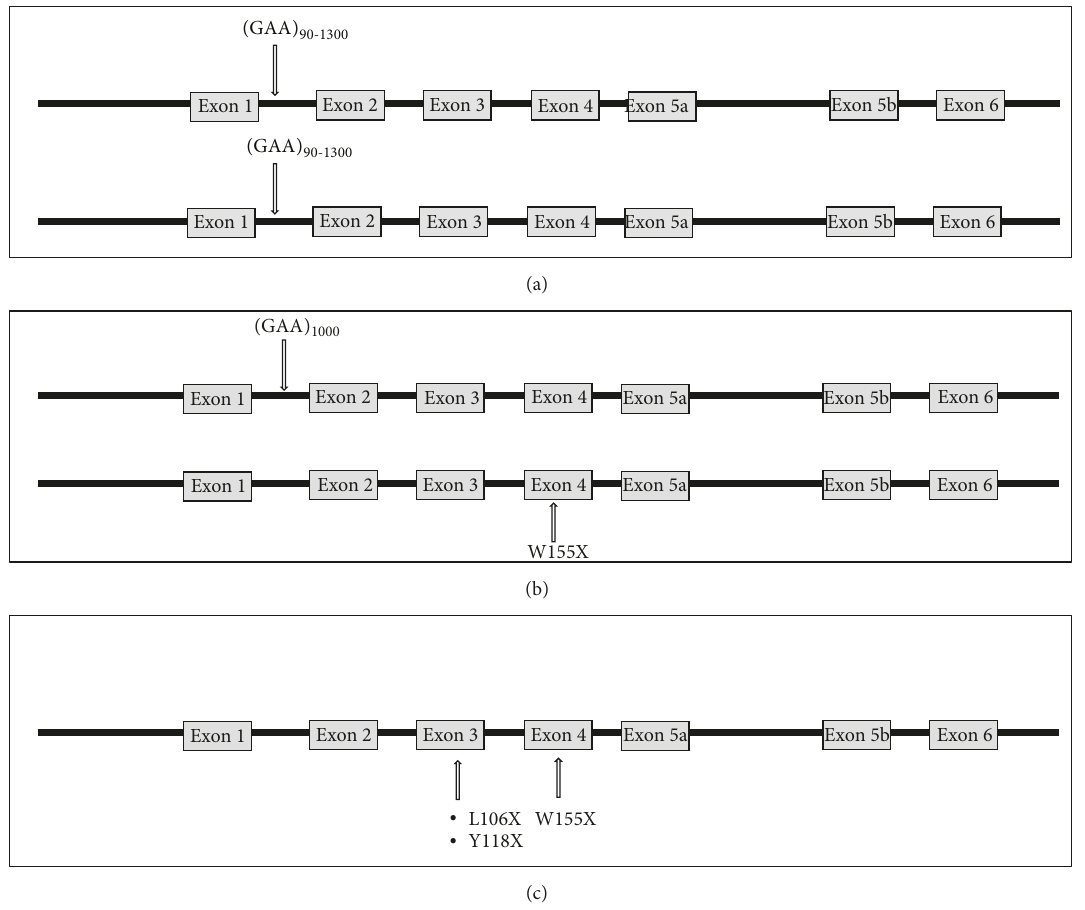
Figure 1: (a) Homozygous GAA triplet repeat expansion. (b) Compound heterozygosity with a point mutation in the second allele resulting in a stop codon, as in our patient. (c) Other known compound heterozygous cases resulting in a nonsense mutation from review of